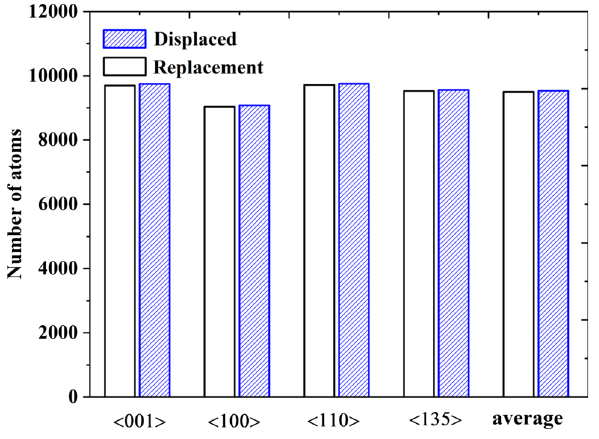
Fig. 9 Curve of the In fixed point phase change process, the phase change inflection point, and the selection of the supercooling